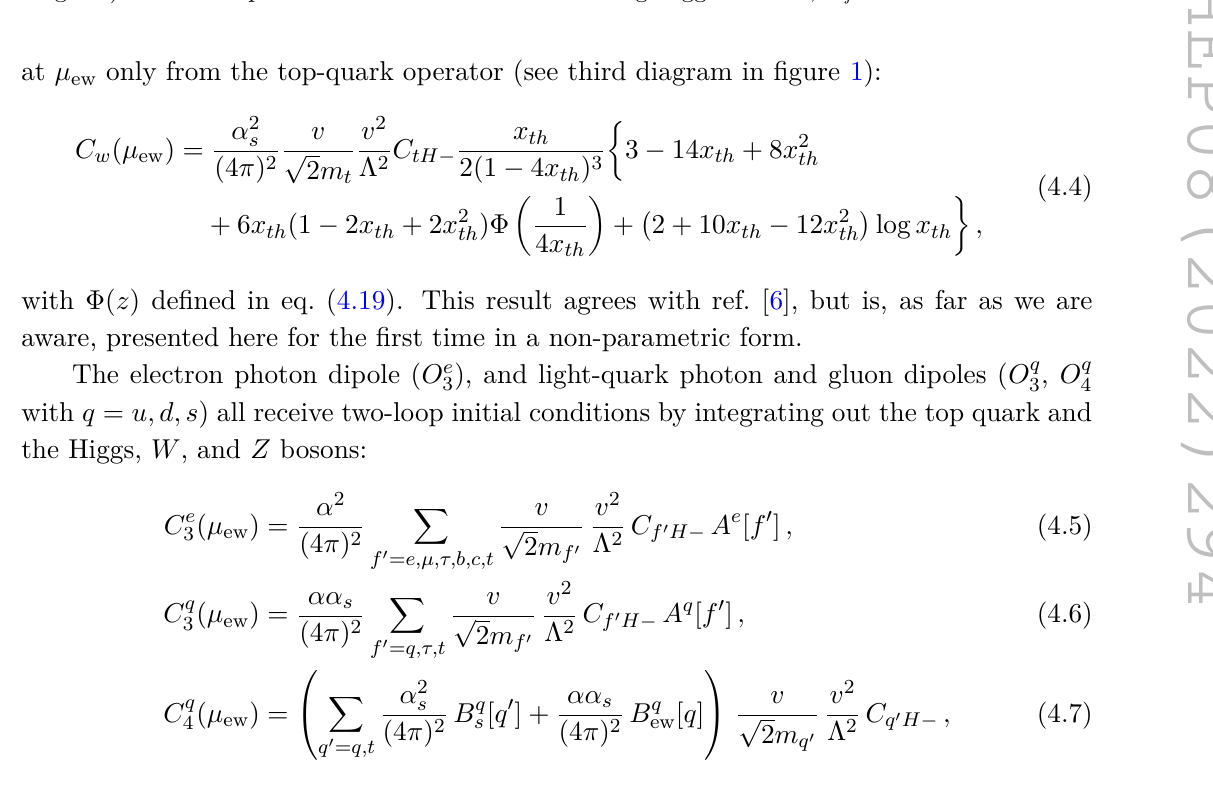
Figure 1 . Sample Feynman diagrams contributing to the tree-level matching of four-quark op- erators (first two diagrams) and the two-loop matching inducing the Weinberg operator (third diagram). The red square vertex indicates a CP-violating Higgs Yukawa, C fH −